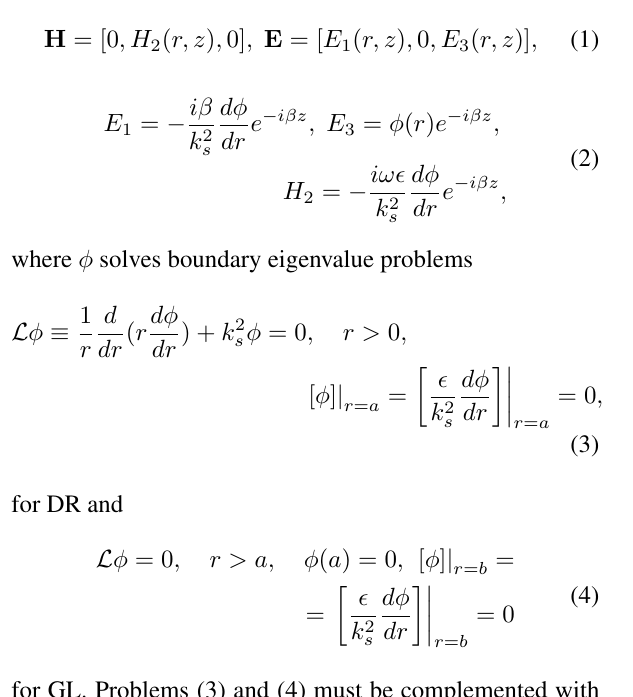
Figure 1: Dielectric rod and Goubau line. Here, β is the wave propagation constant (spectral pa- rameter), and k 0 is the free-space wavenumber. The sym- metric (azimuthally-independent) waves have the nonzero